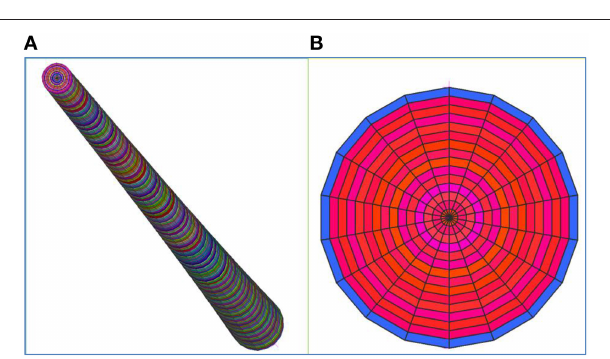
FIGURE 6 | A 64,800 brick element FE model, with a maximum aspect ratio of about 10, was selected as optimum for carrying out the finite element analyses. The cocowood optimum FE model included 240, 18, and 15 divisions, axially, peripherally, and radially, respectively. The whole domain in the FE model was meshed with 65,311 nodes. (A) Axial perspective of the characteristic coconut stem model, (B) Cross-sectional area at the bottom of the model. Note that the color coding in the figure is reflecting brick elements with different